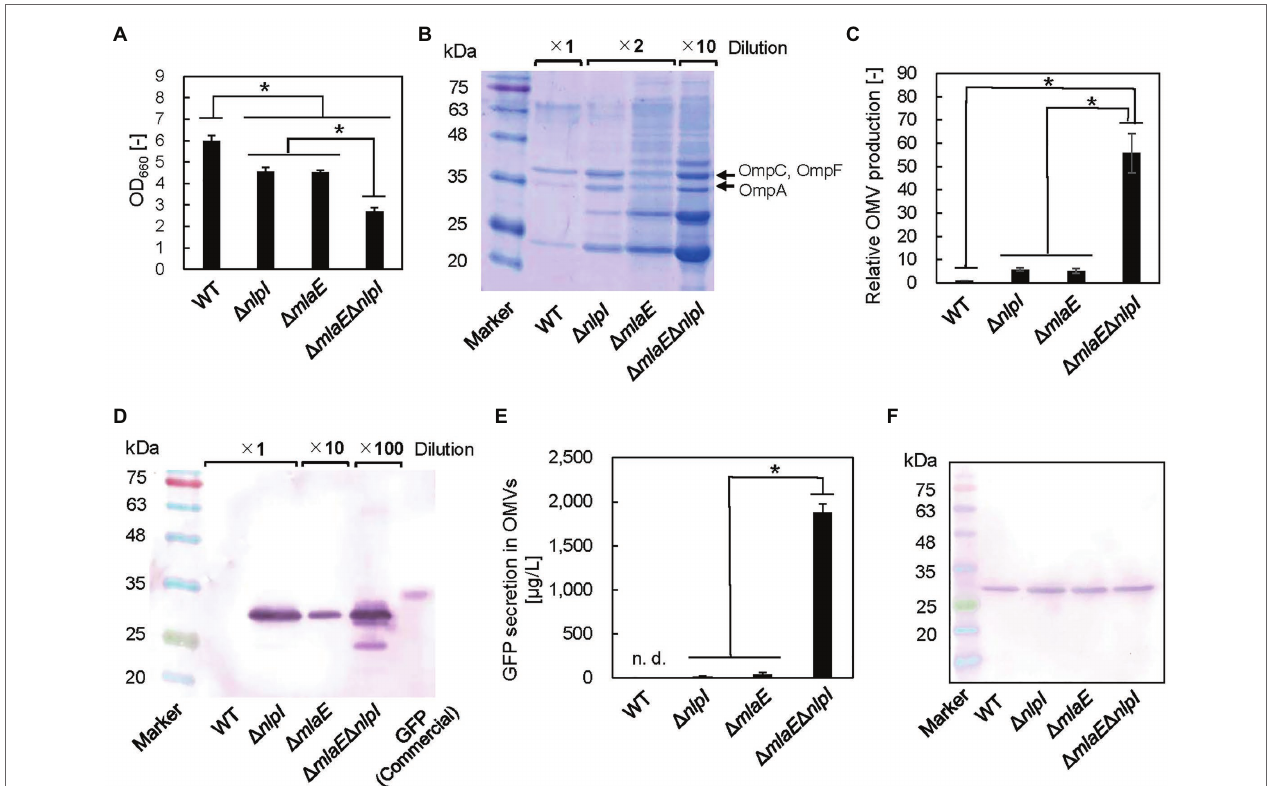
FIGURE 6 | Green fluorescent protein (GFP) secretion in the OMV fraction isolated from each E. coli strain. (A) OD 660 of each E. coli strain after 24 h in culture. (B) Sodium dodecyl sulfate–polyacrylamide gel electrophoresis (SDS-PAGE) analysis of the OMVs isolated from each E. coli strain. (C) Relative OMV production by each E. coli strain normalized to that by the WT strain. (D) Western blot analysis of secreted GFP using an anti-His-tag primary antibody. (E) Quantitative evaluation of GFP secretion in the OMV fractions of corresponding E. coli strains. (F) Western blot analysis of the GFP produced in each E. coli strain. Loading samples were prepared on an OD 660 basis to include the same quantity of cells. Values were quantified on the basis of a GFP standard sample. The data are expressed as the mean of three independent experiments ( n = 3) and SD (vertical bar). An asterisk indicates the statistical significance as determined by ANOVA with Tukey’s test ( p <